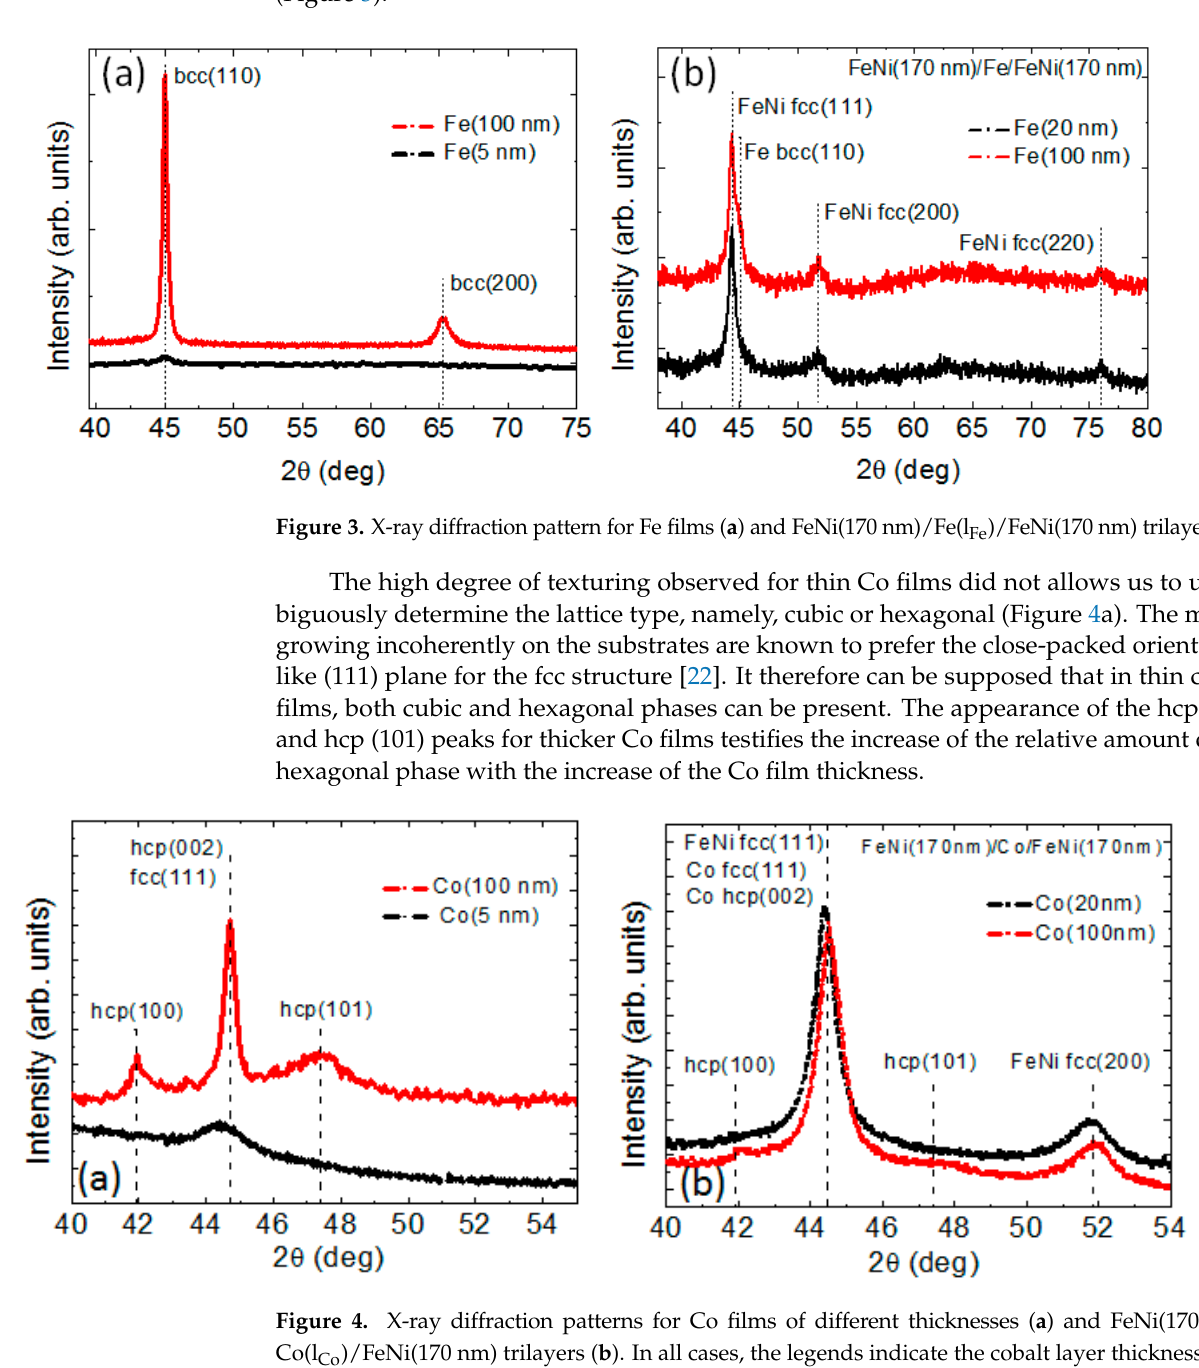
Figure 4. X-ray diffraction patterns for Co films of different thicknesses ( a ) and FeNi(170 nm)/Co(l Co )/FeNi(170 nm) trilayers ( b ). In all cases, the legends indicate the cobalt layer thickness.